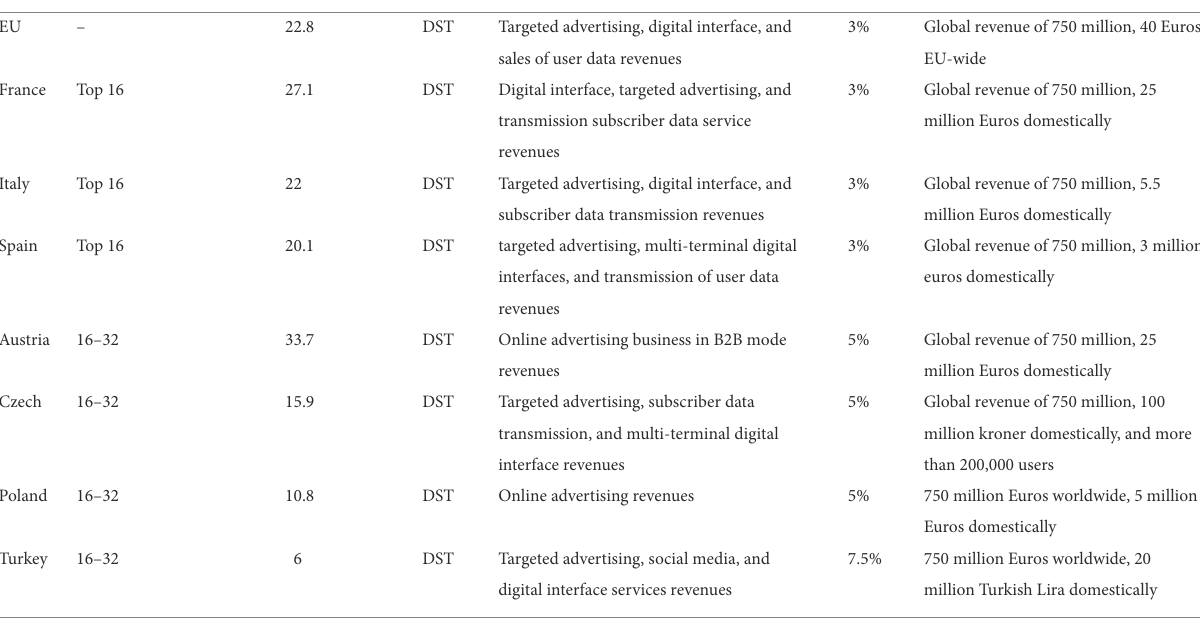
TABLE 1 First option unilateral digital taxation scheme for major